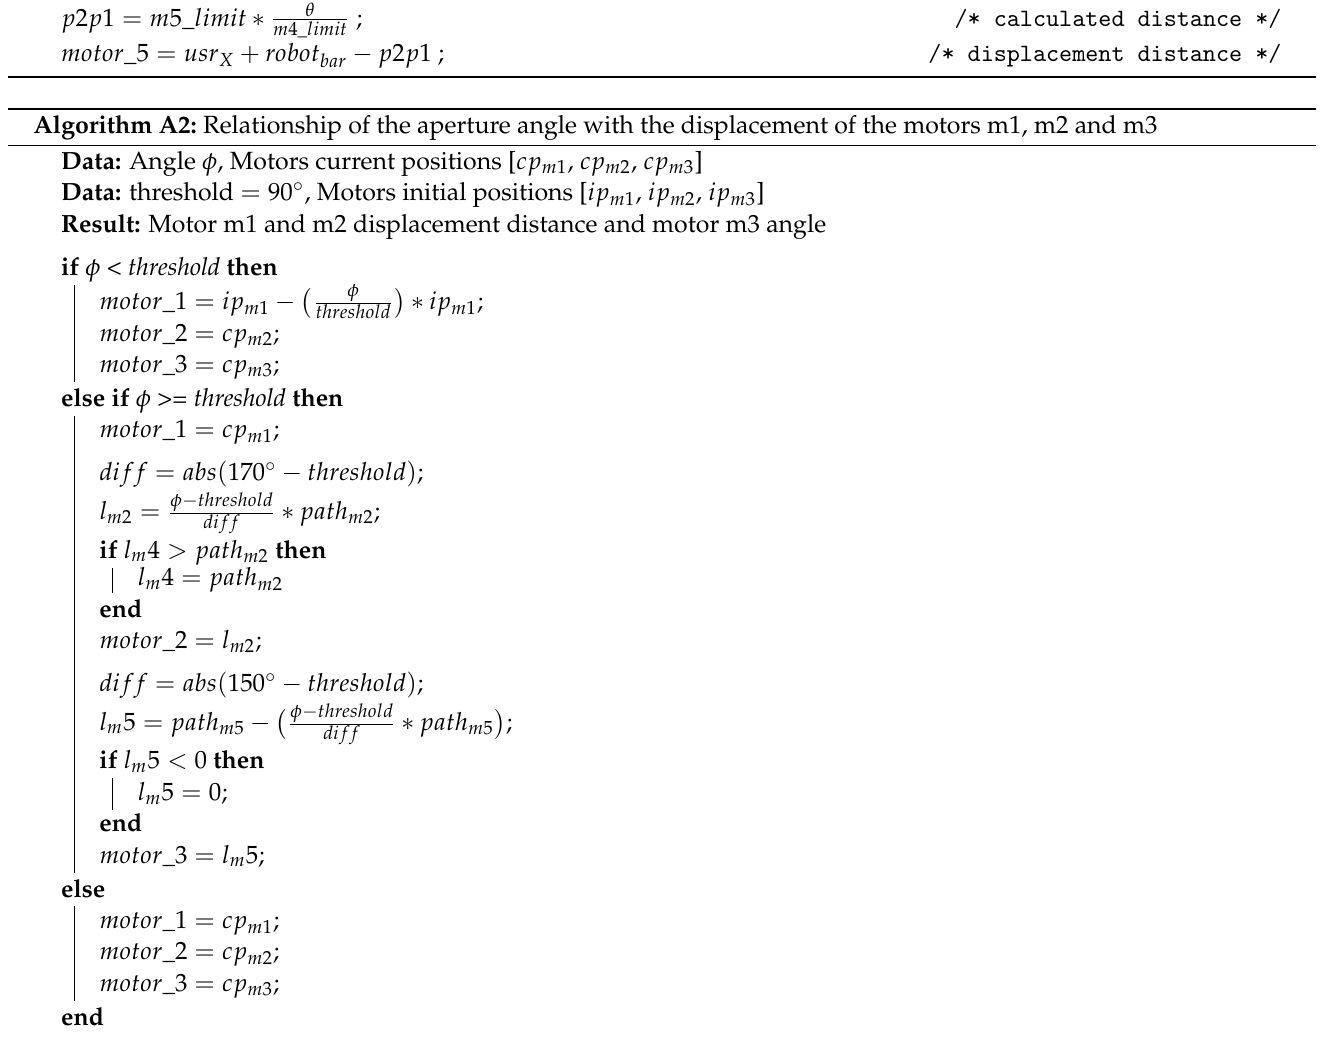
Algorithm A1: Relationship of the aperture angle with the displacement of the motors m4 and m5 Data: θ , m 4_ limit , m 5_ limit , usr X , robot bar Result: Motor 5 displacement distance